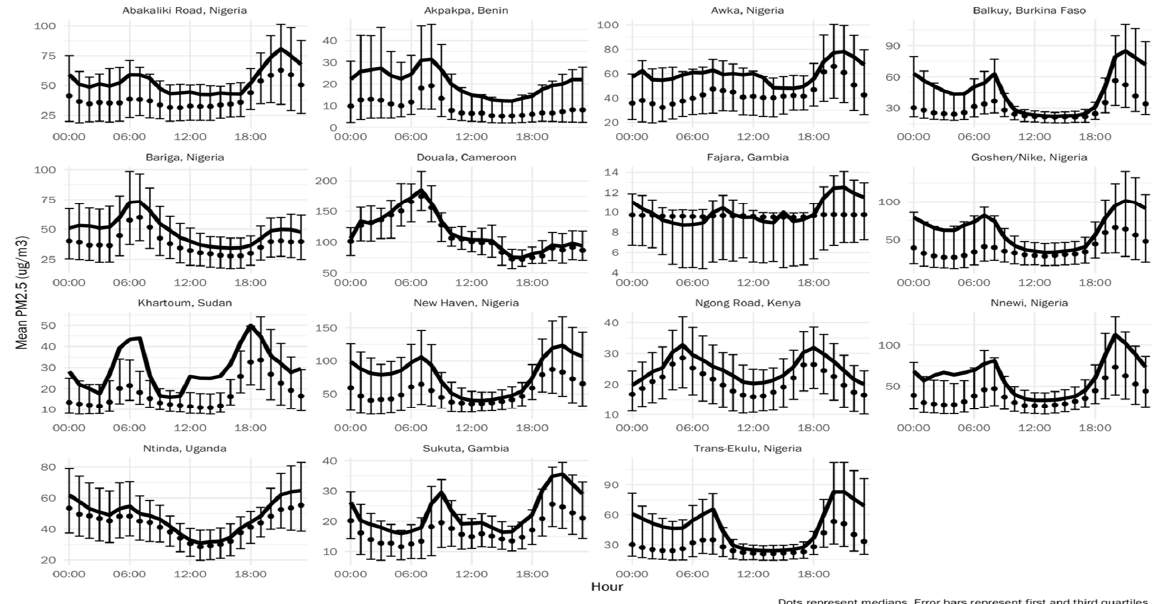
Figure 5. Diurnal variation at each study site.